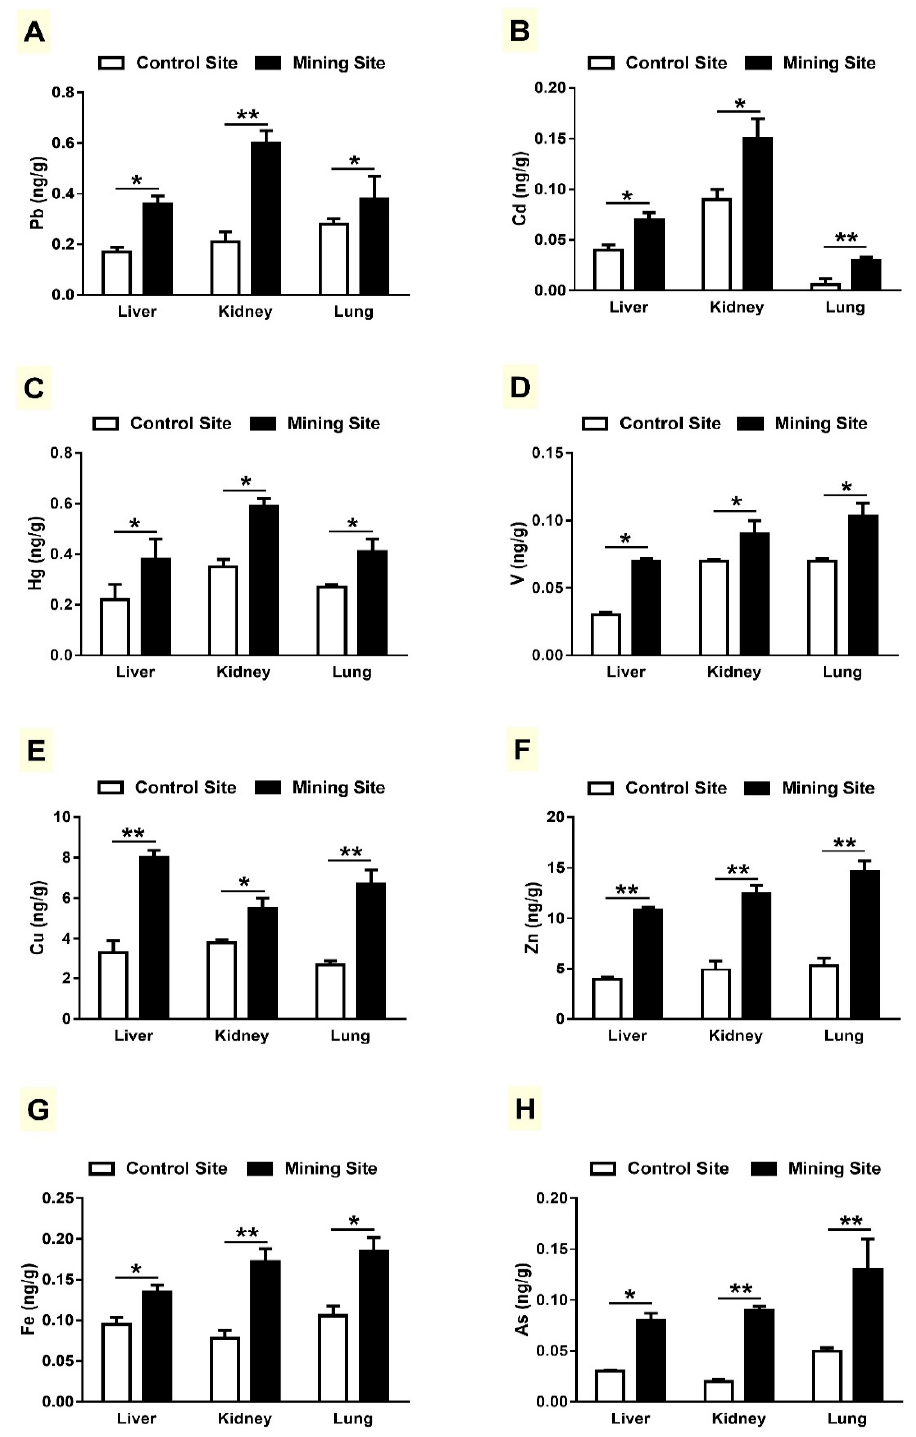
Figure 3. Concentration of heavy metals in the liver, kidneys and lungs of G. nanus from the mining and control sites. Data are means ± SEM, ( n = 8). * p < 0.05 and ** p <